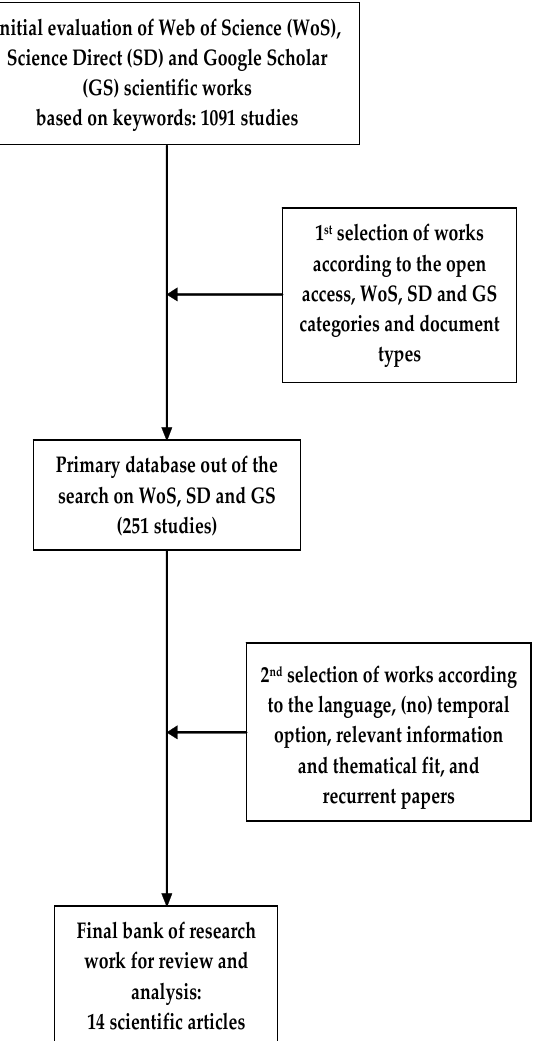
Figure 2. The methodical review process scheme.